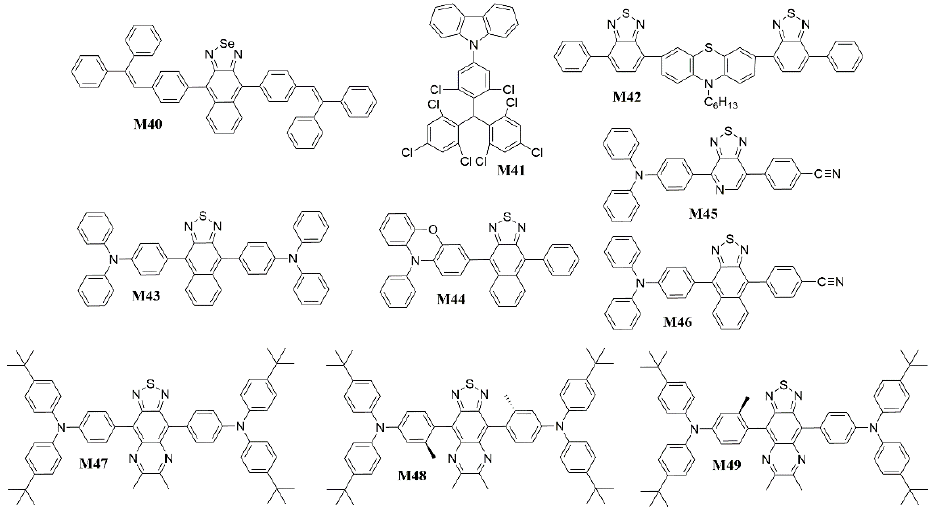
Figure 14. Chemical structures of M40 to M49 .